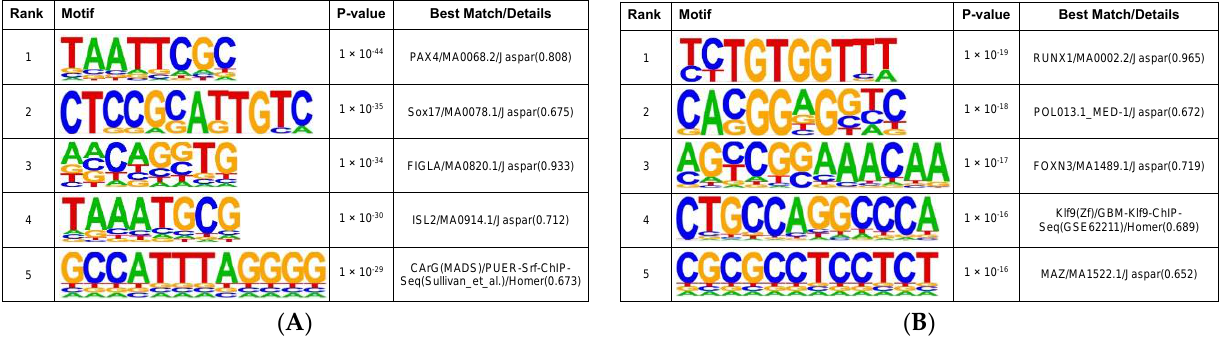
Figure 4. DNA methylation differences in TYAs across medulloblastoma molecular subgroups. ( A ) Top five binding motifs identified by HOMER based on DMPs with high methylation levels in TYAs in the entire dataset. ( B ) Top five binding motifs identified by HOMER based on DMPs with low methylation levels in TYAs in the entire dataset.